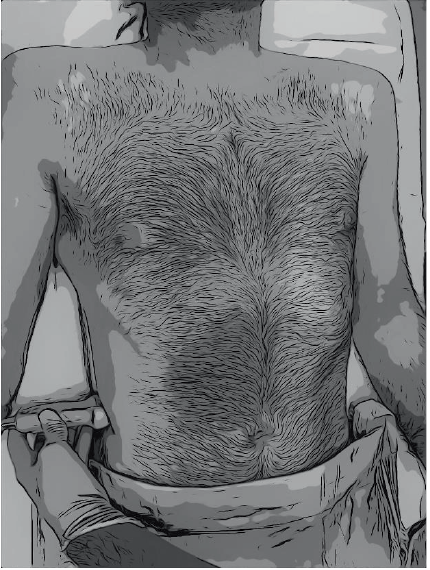
Figure 2: Placement of linear ultrasound transducer on the posterior aspect to allow visualization of posterior aponeurosis of the transversus abdominis muscle.